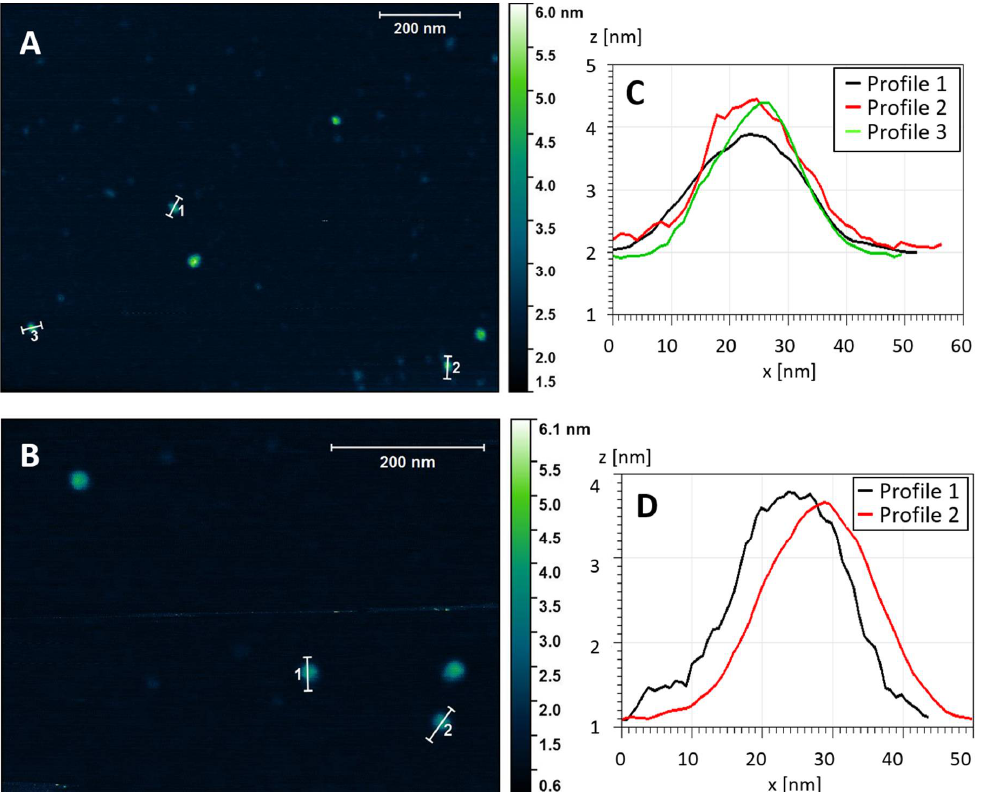
Figure 3. Topography of the stab-1 HCC oligomers. Selected AFM images of the stab-1 HCC oligomers ( A , B ) and cross-sectional profiles of the indicated oligomers in the images ( C , D ). The height profiles (z (nm)) are presented for the indicated oligomers from panel ( A ) (1–3) and panel ( B ) (1, 2). From this analysis the diameter (x (nm)) can be approximated.